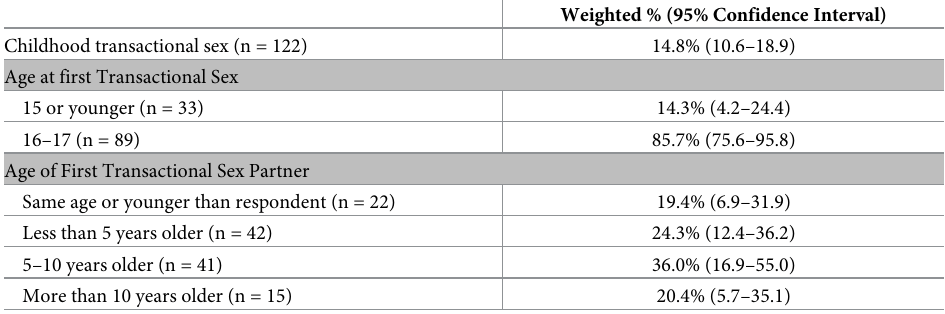
Table 2. Prevalence and characteristics of first experiences of childhood transactional sex among females ages 18– 24 who ever had sex prior to age 18, Uganda Violence Against Children Survey